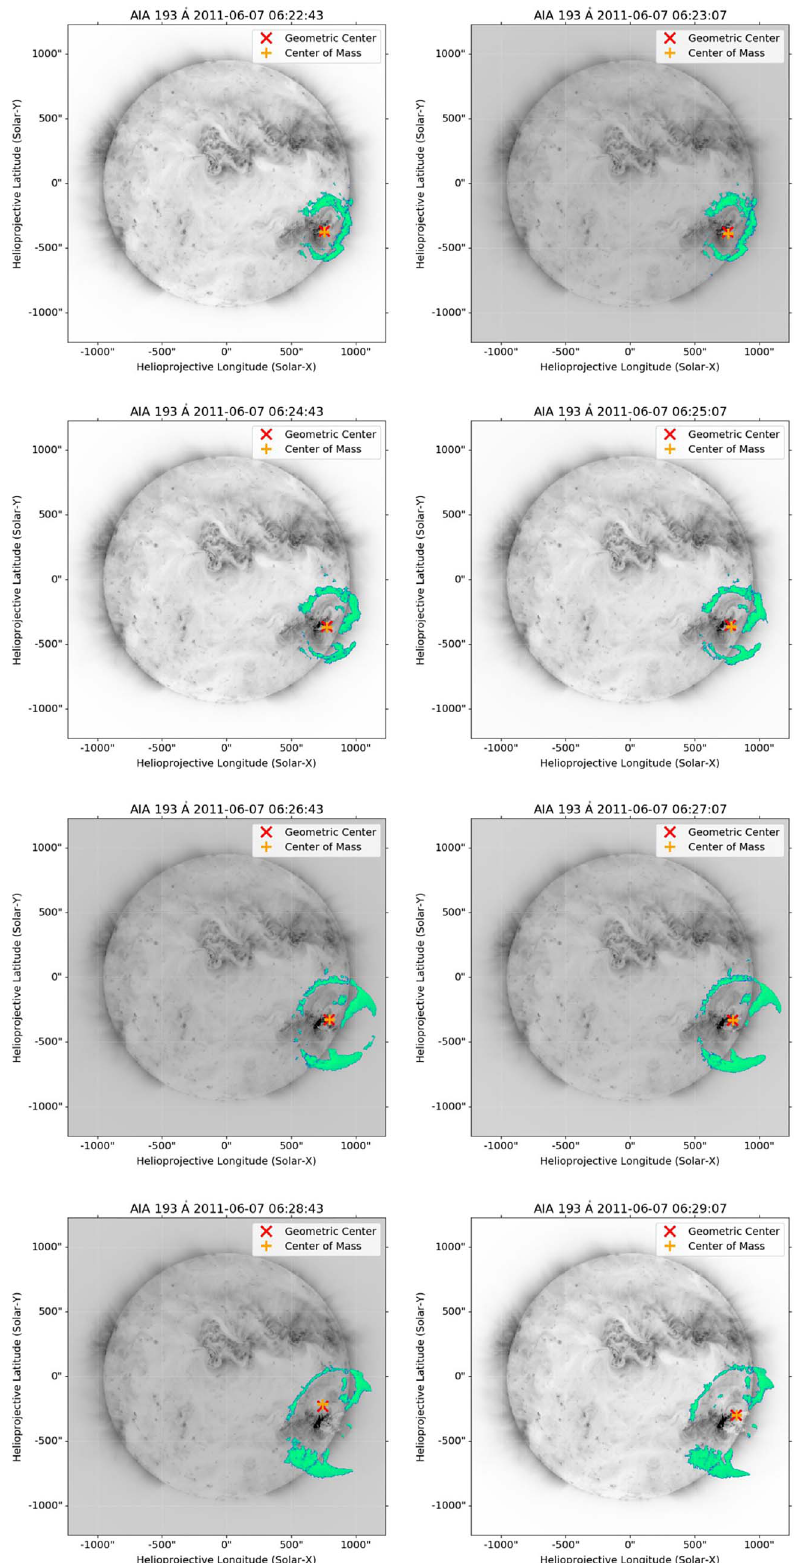
Fig. 9. The wavetrack output for four pairs of consecutive images separated by 2 min during the eruption of June 07, 2011, similar to Figure